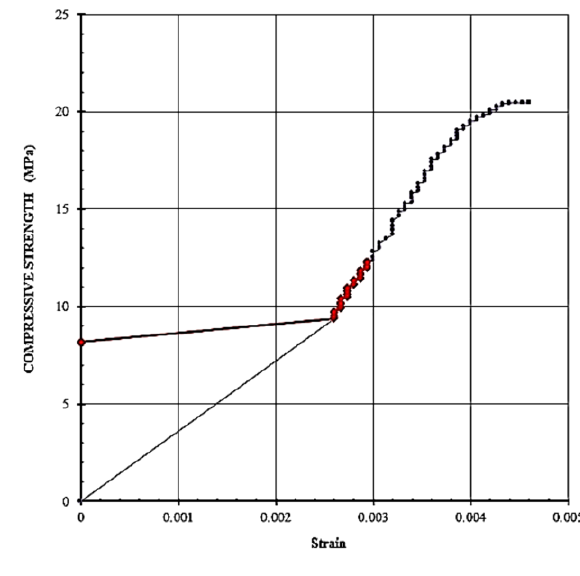
Figure. 10 . Elastic modulus of 40 % recycled aggregate